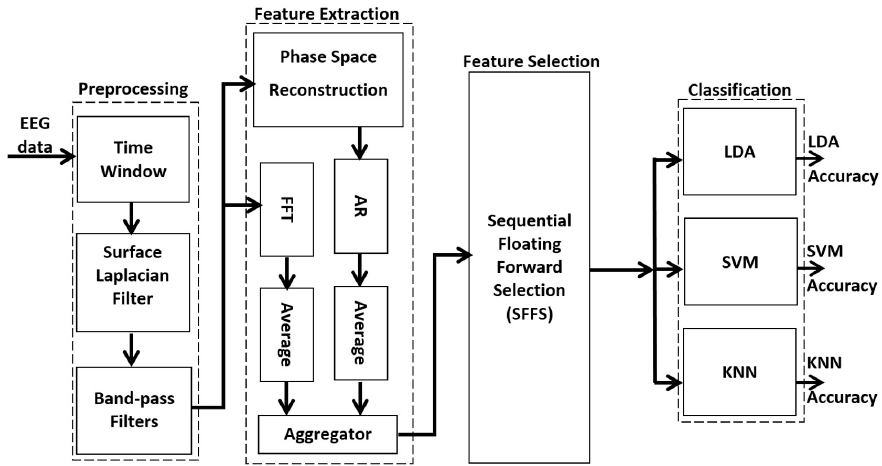
Figure 1. Proposed framework for MI-BCI multi-class classification.